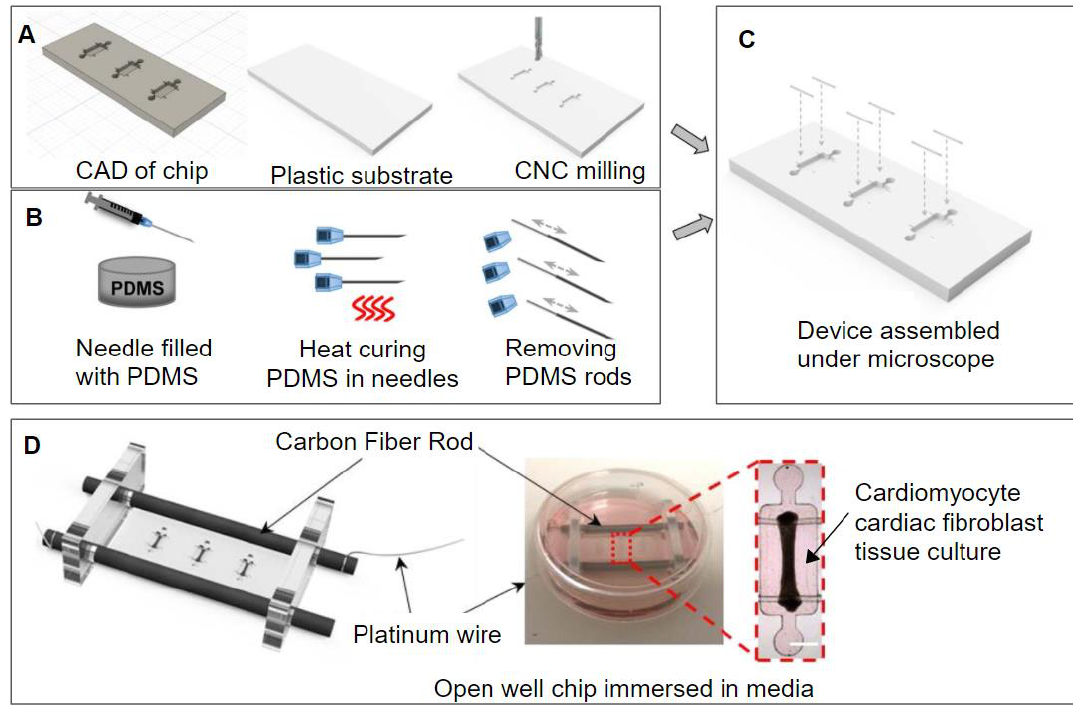
Figure 6. ( A ) using a computer-aided design (CAD) to micromill the microwells out of plastic ( B ) using 27-gauge needles as a mold for the creation of uniform PDMS rods. ( C ) the assembly of the